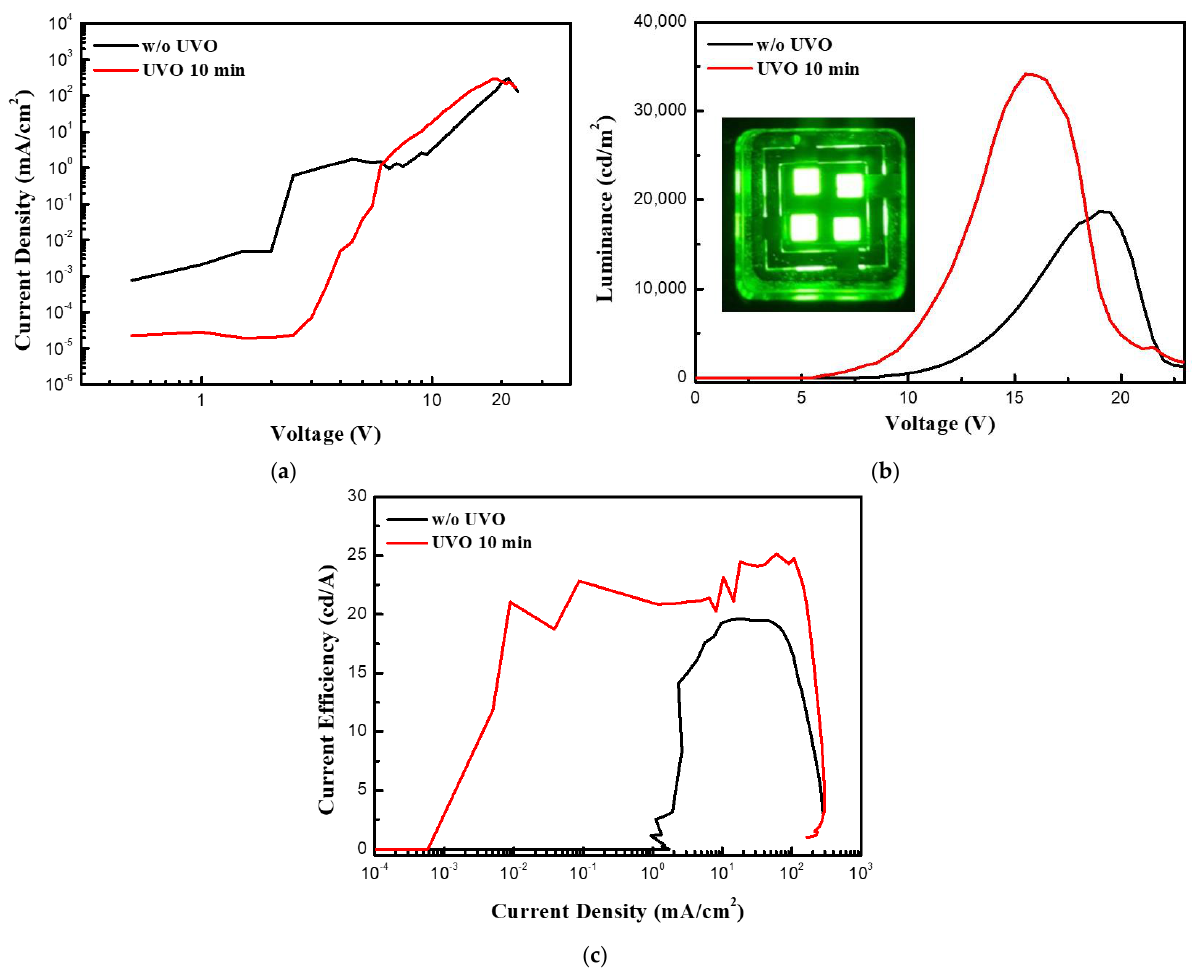
Figure 6. ( a ) Current density–voltage, ( b ) luminance–voltage, and ( c ) current efficiency–current density characteristics of QLEDs using NiO with and without UV-ozone treatment.